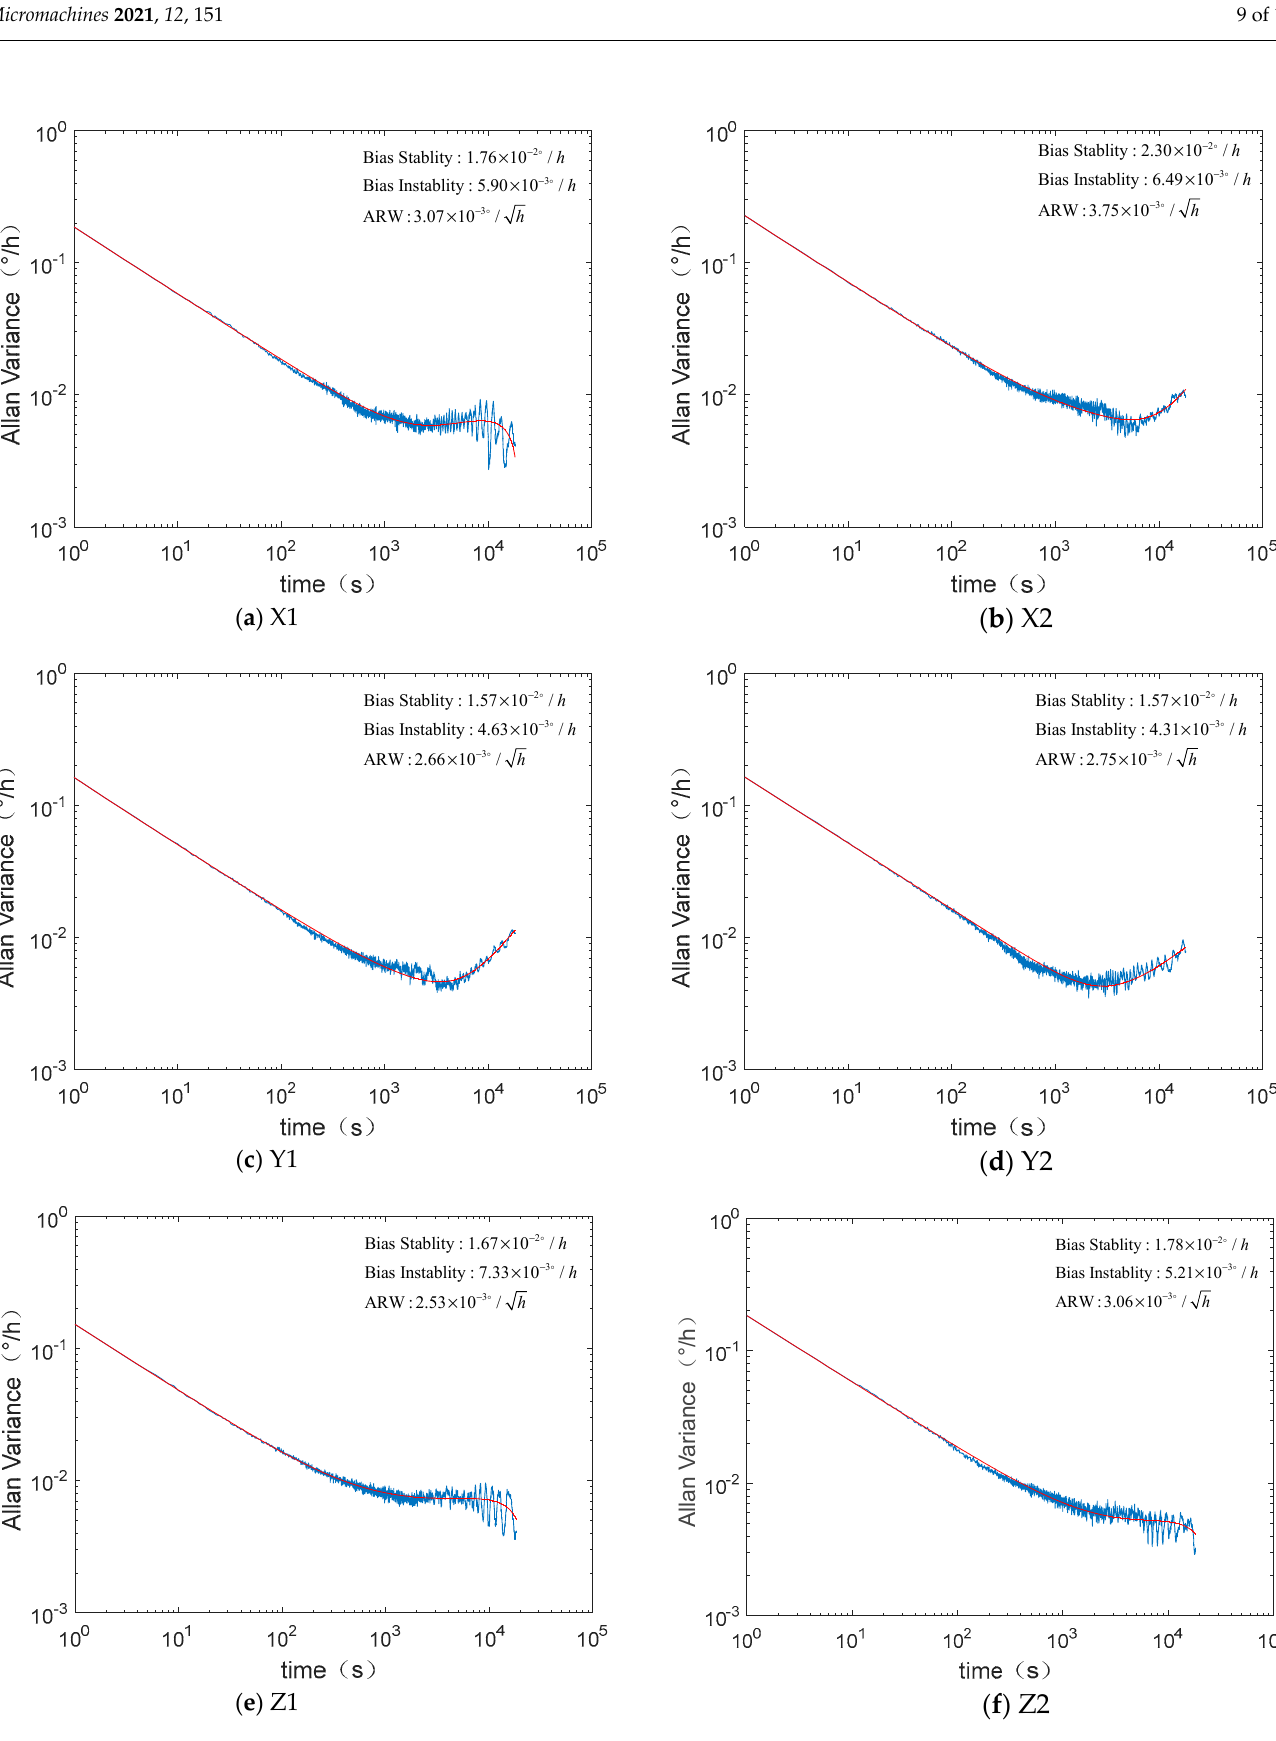
Figure 9. Allan variance curves of the six MEMS gyroscopes in the IMU tested 4 months later. The Lobster-Eye X-ray Satellite employed a MEMS IMU and a navigation grade fiber optic gyroscope (FOG) unit weighing 430 g. The in-orbit data of the MEMS unit transmit- ted from the satellite and the FOG unit almost completely overlap each other, as displayed in Figure 10, which means that the output and control effect of the MEMS IMU is similar